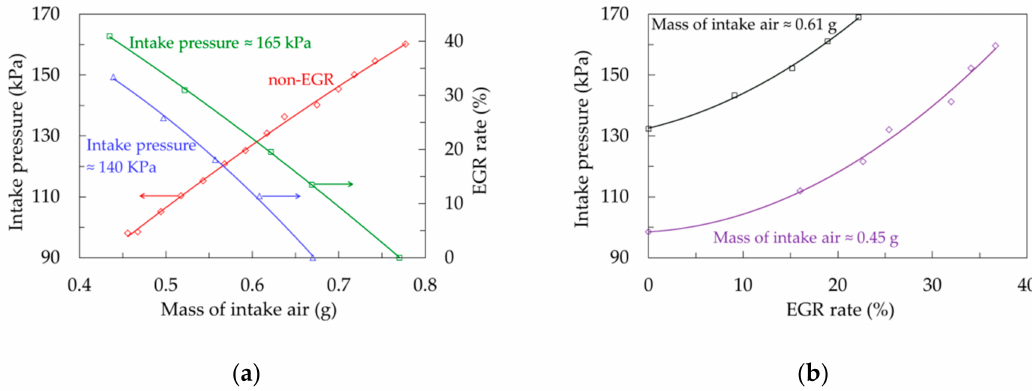
Figure 4. Explored intake gas conditions relevant to UEGO signal quality: ( a ) EGR sweeps at constant pressure and pressure sweep at non-EGR; ( b ) intake pressure and EGR relations at constant amounts of in-cylinder